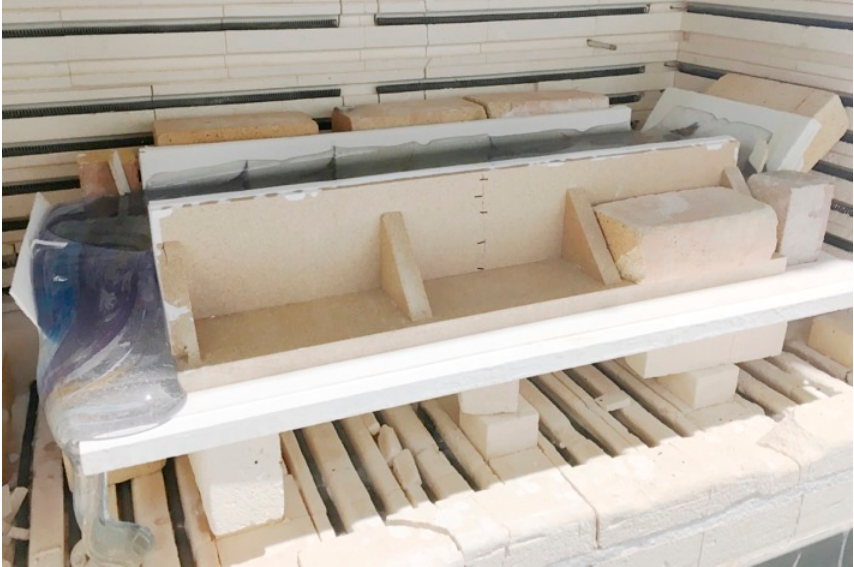
Figure 2. Kiln setup for failed fusing of Encyclopaedia. Photo: The Author.